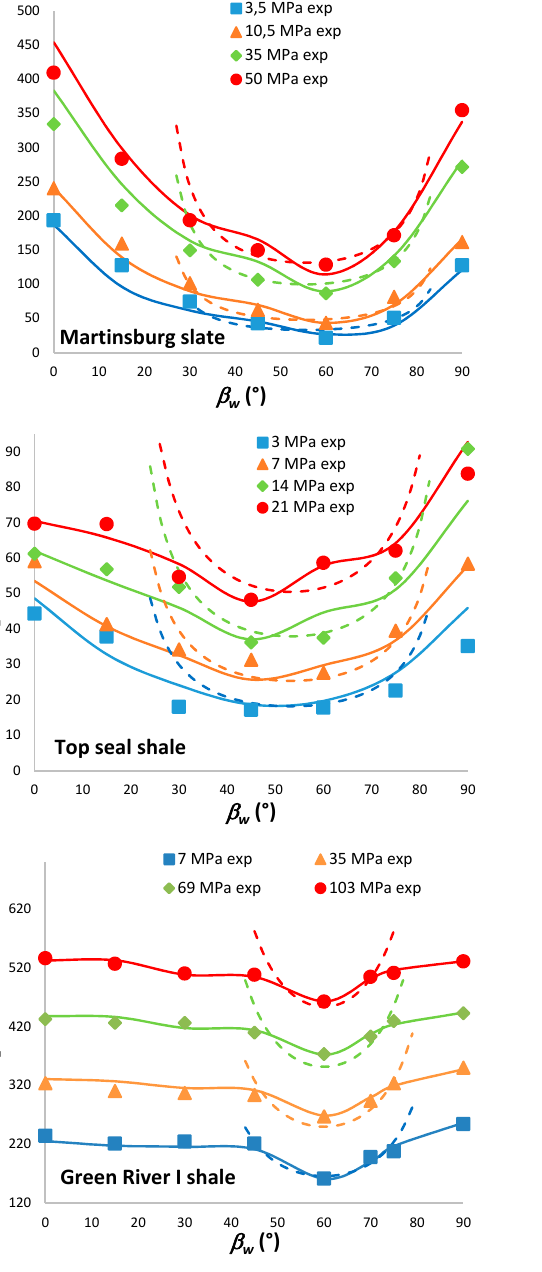
Figure 4. Results of the triaxial tests carried out at different inclinations of the weakness planes. Experimental data (filled symbols) and simulations carried out with Hoek and Brown criterion from the data of the linear regressions (solid lines) and with weakness plane model (dotted lines). The data of the triaxial tests are reported by: [34] (Top seal shale); [41] (Artificial rock); [30] (Martinsburg slate); [52] (Bossier shale); [37] (Green River I shale); [53] (Longmaxi shale).